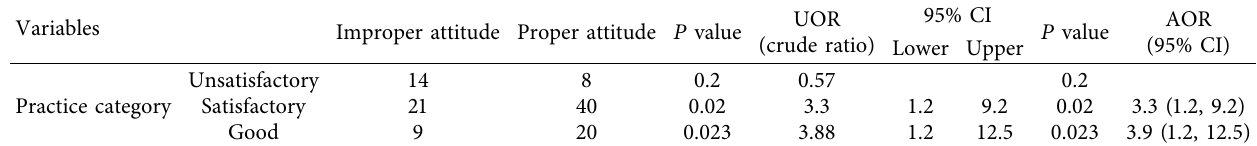
Table 9: Association between attitude and practice regarding physical restraint use in bivariate analysis ( n � 112).